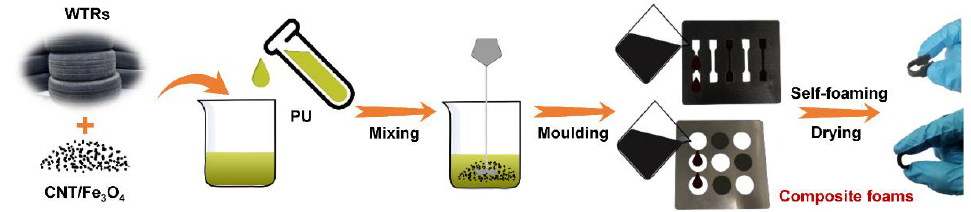
Figure 1. The schematic diagram of fabricating the PU/WTR@CNT/Fe 3 O 4 composite